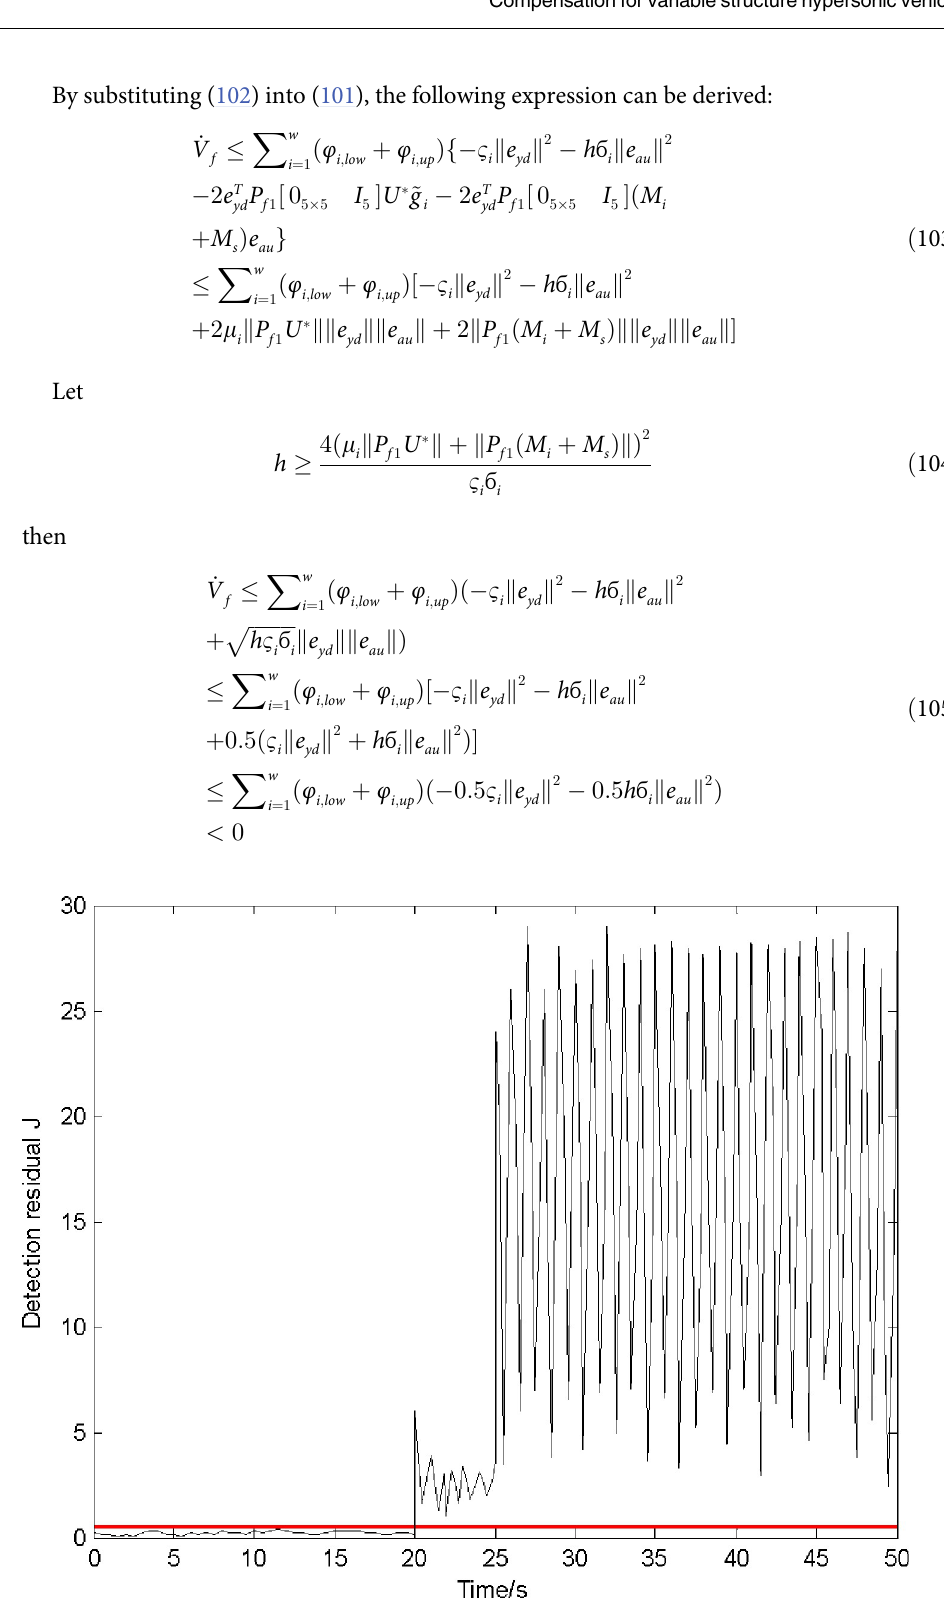
Fig 3. Detection residual and